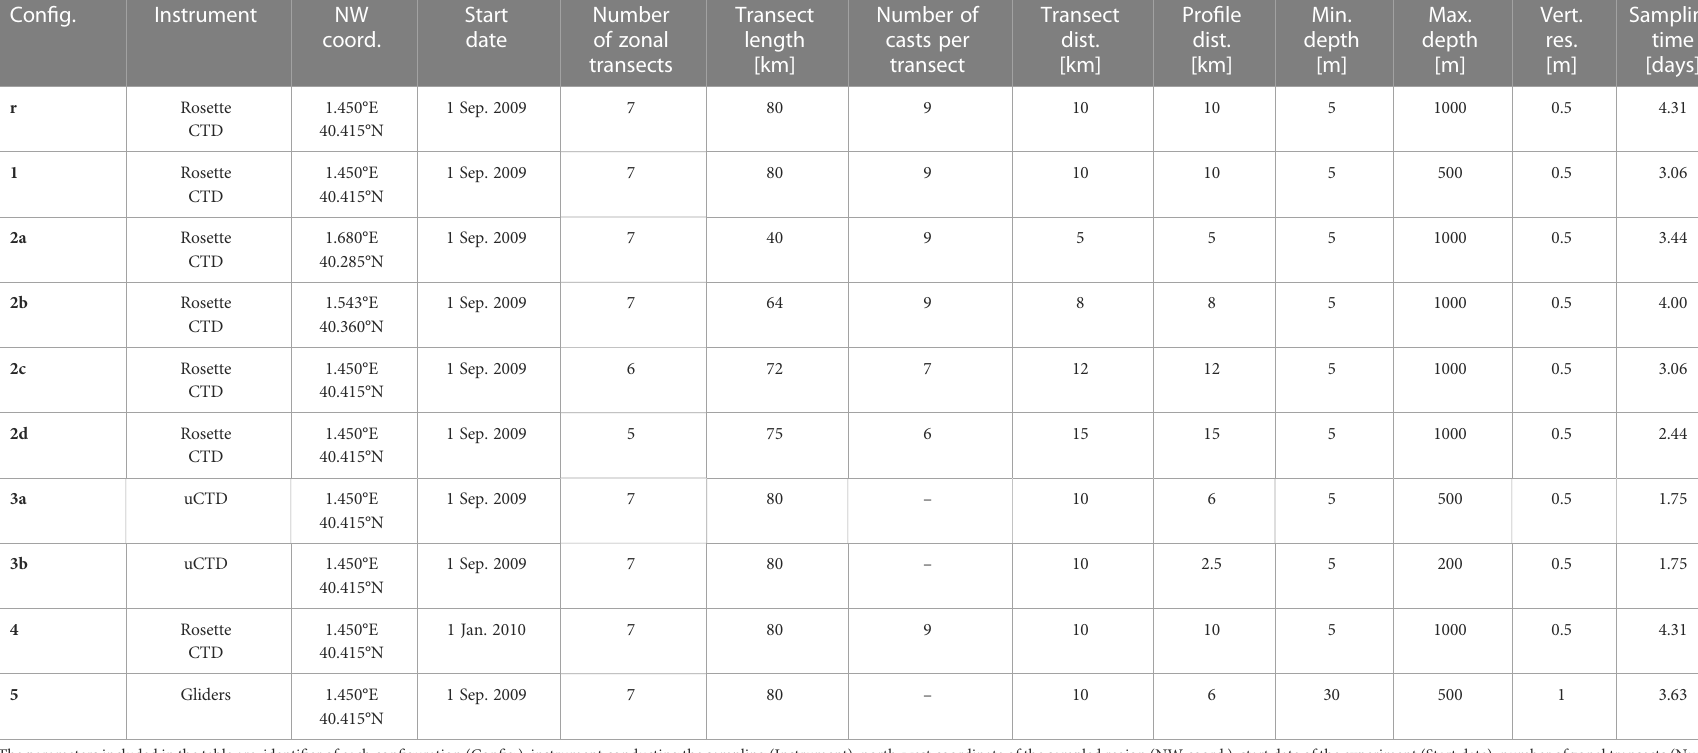
TABLE 1 Description of the con fi gurations simulated in the Mediterranean study region. Con fi g. Instrument NW